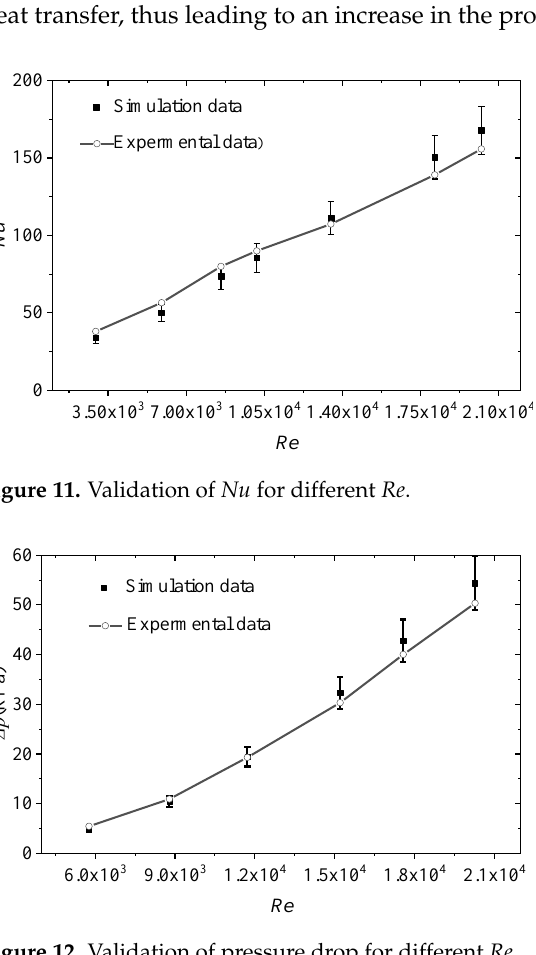
Re Expermental data 64/ Re Blasius,f( Re ) Figure 10. Drag coefficient with experimental data under constant Re . 4.3. Comparison of Experimental and Numerical Simulation